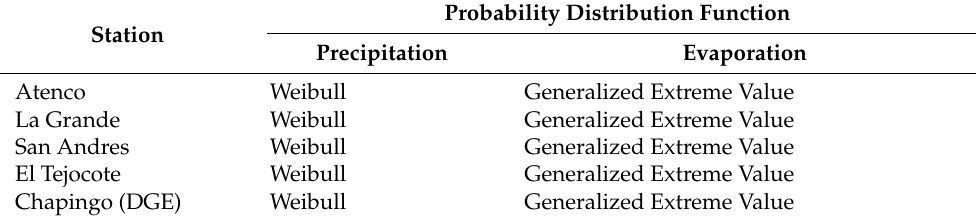
Table 2. Selected distributions for all variables and